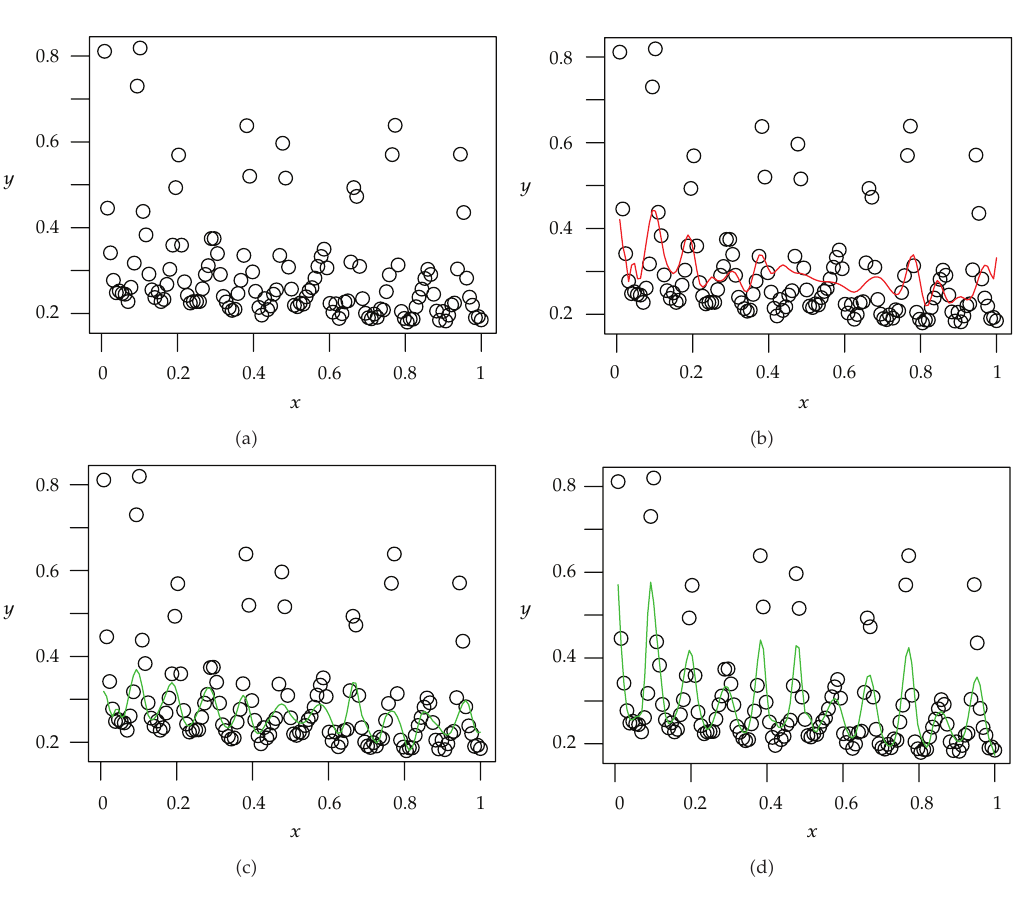
Figure 5: Curve estimation for the first data: (cid:5) a (cid:6) noisy data, (cid:5) b (cid:6) the fitting by (cid:7) 5 (cid:8) , (cid:5) c (cid:6) the fitting by first proposed method, and (cid:5) d (cid:6) the fitting by the second proposed